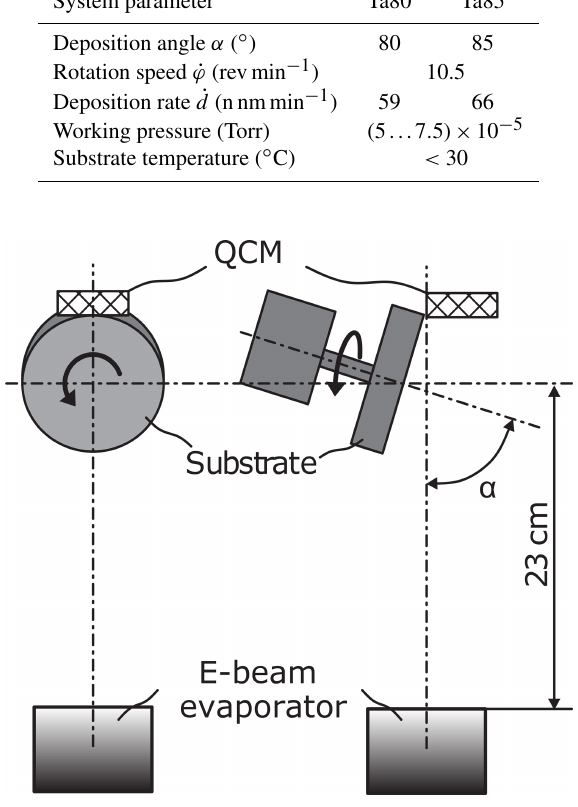
Figure 1. Setup of the GLAD apparatus adapted from Schossig (2012a, p. 90) (QCM – quartz crystal